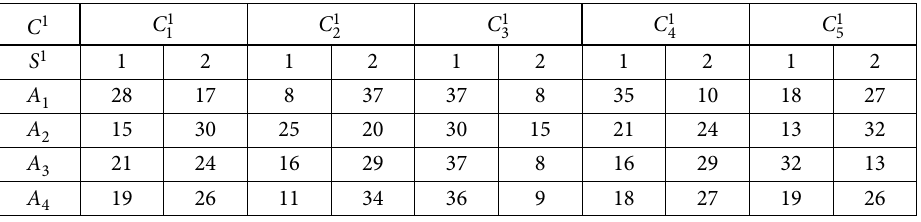
Table 2. Dynamic distribution of the number of visitor evaluation Data from the first survey